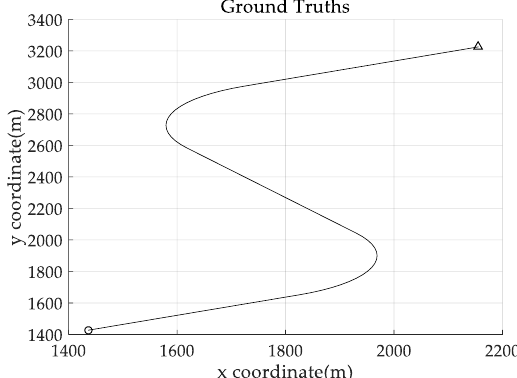
Figure 8. True trajectory of the target moving on a curved road: “ ○ ” : location at which the target starts; “ △ ” : location at which the target stops. Table 3. Average OSPA distances and running times of different filters versus detection probability, for a clutter rate of 60.